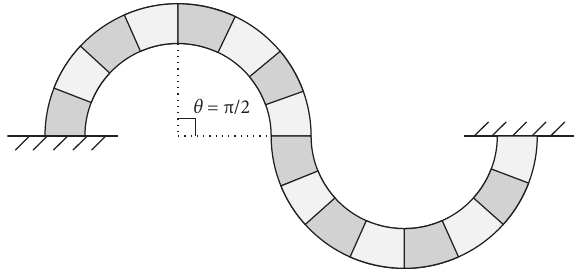
Figure 14: Eight period composite curved beam model. Table 4: Material